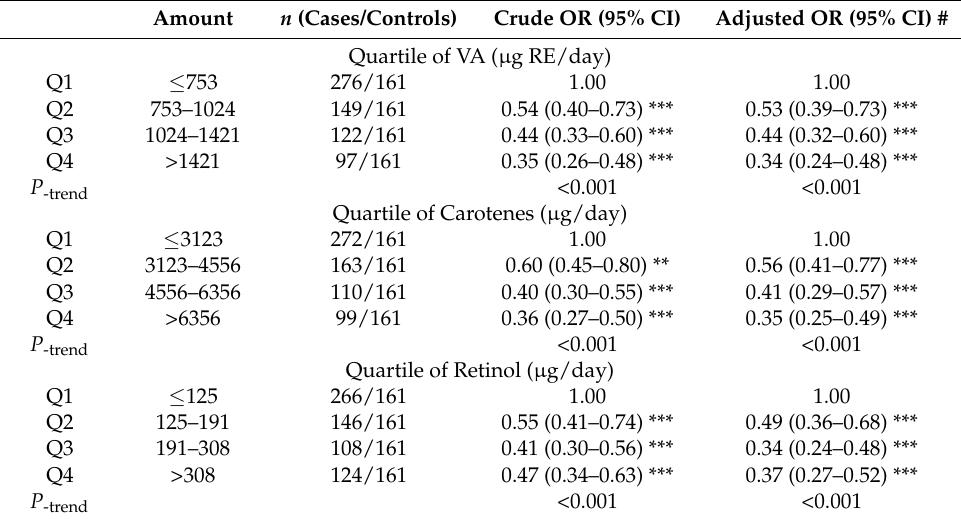
Table 3. Odds ratios (OR) and 95% confidence intervals (CI) of primary liver cancer according to quartiles of vitamin A, carotenes, and retinol